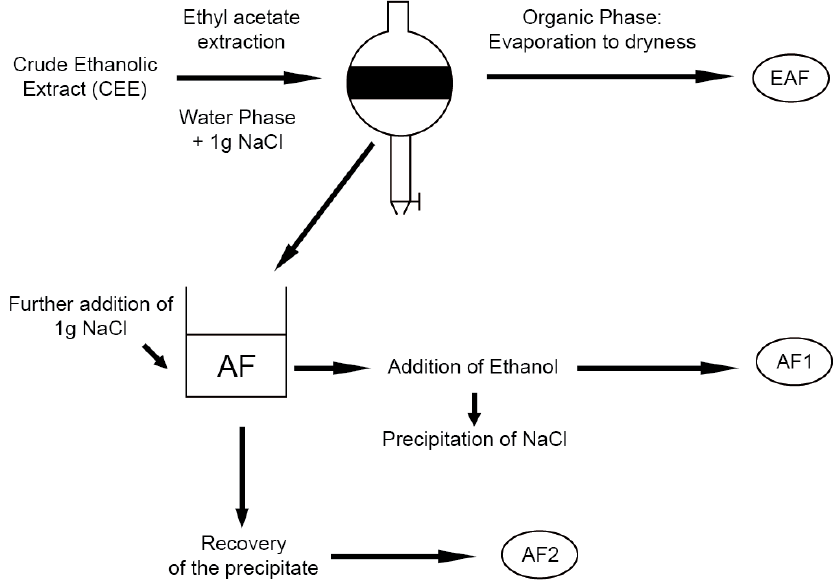
Figure 5. Scheme for fractionation of the CEE. EAF = Ethyl acetate Fraction, AF = Aqueous Fraction, AF1 = Aqueous Fraction 1, AF2 = Aqueous Fraction 2.